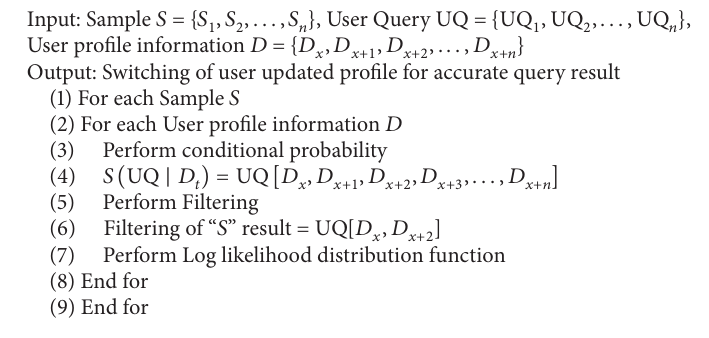
Algorithm 1: Algorithm of regime switching.